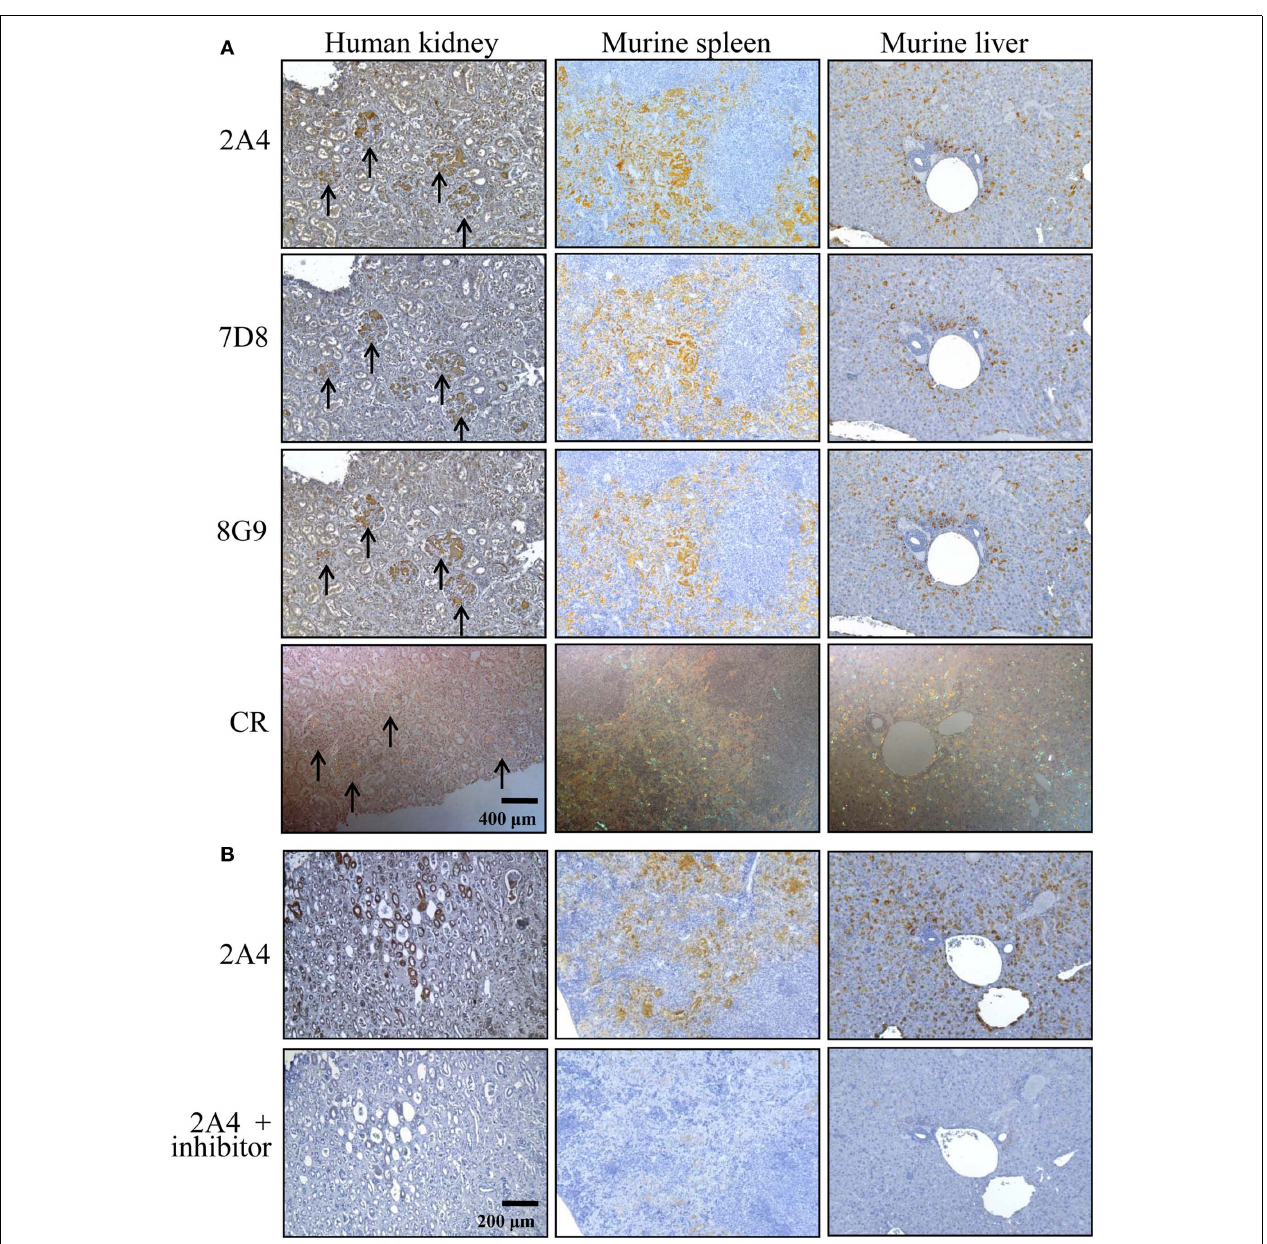
FIGURE 4 | Immunostaining of human and murineAA deposits by mAbs 2A4, 7D8, and 8G9. (A) Interaction of the antibodies with AA amyloid contained in sections of H2-L d -huIL-6 mouse-derived spleen and liver, as well as human kidney, compared favorably with the distribution of amyloid evidenced by Congo red staining. (B) Binding of mAb 2A4 absorbed with (upper) the GHEDTMADQE peptide or (lower) the GHEDT immunogen. Original magnifications, × 40.